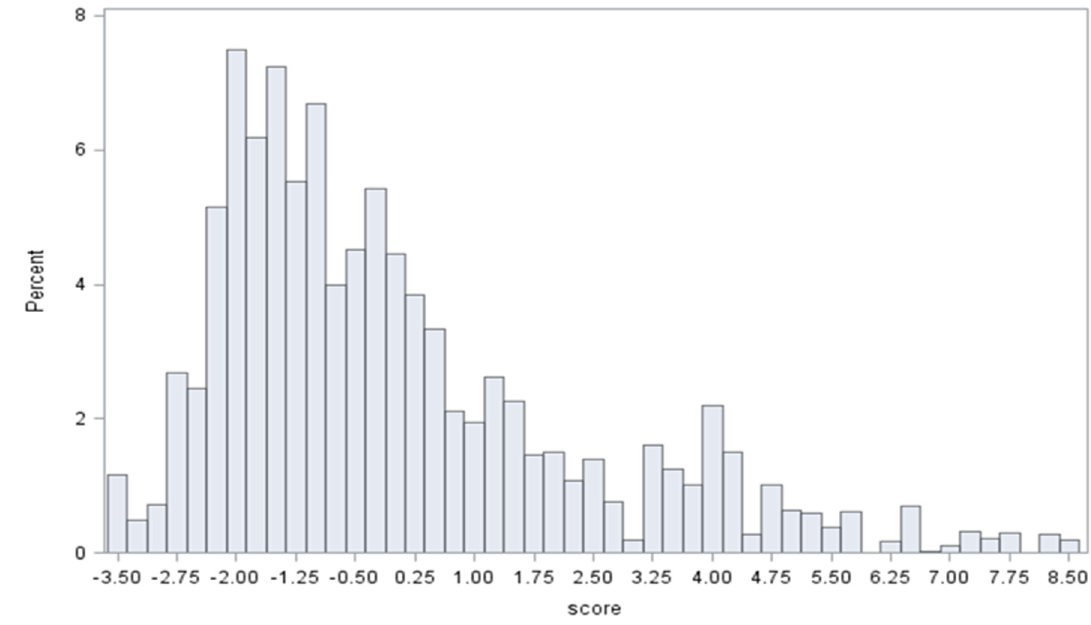
Figure 2. Distribution of area deprivation scores: Below is a histogram depicting the distribution Messer Area Deprivation Index (ADI) scores before tertiles were formed. Tertile 1(least deprived): ADI < − 1.399. Tertile 2 (moderately deprived): − 1.399 < ADI < 0.288. Tertile 3(most deprived): ADI > 0.288.